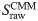
Comparison of the interface-level scoring functions using CMM.The fraction of proteins for which there is at least one near-native complex in the top predictions, for the scoring functions SCMM (black dash-dotted line), SrawCMM (light grey dash-dotted line), S(SRP, SN, Sent) (grey solid line), S(SRP, SN, Sent, SCMM) (black solid line) and S(SRP,SN,Sent,SrawCMM) (light grey solid line).